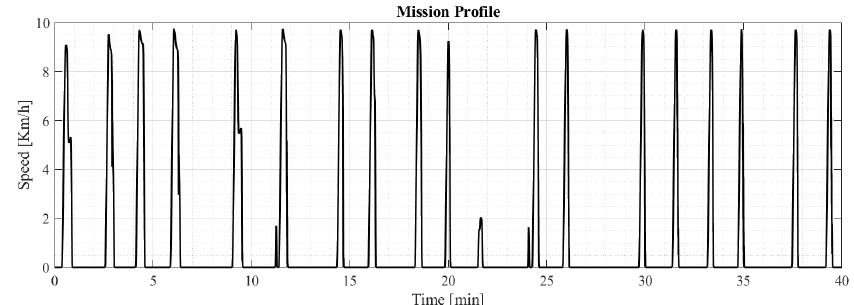
Figure 5. The mission profile of railway vehicle during the forty-minute work